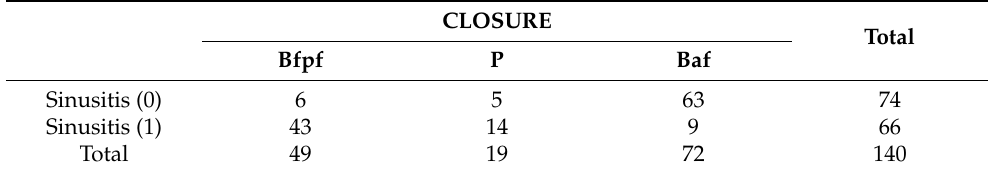
Of the 140 patients treated using buccal advancement flap, Bichat fat pad flap, and palatal flap, almost half presented associated chronic sinusitis (Table 2). Table 2. Flaps used: Bfpf (Bichat fat pad flap), P (palatal flap), Baf (Buccal advancement flap); associated sinusitis (1), no associated sinusitis (0).